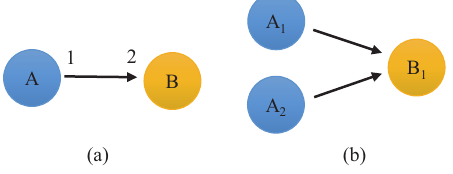
Figure 4. ( a ) SDFG, ( b ) HSDFG converted form ( a